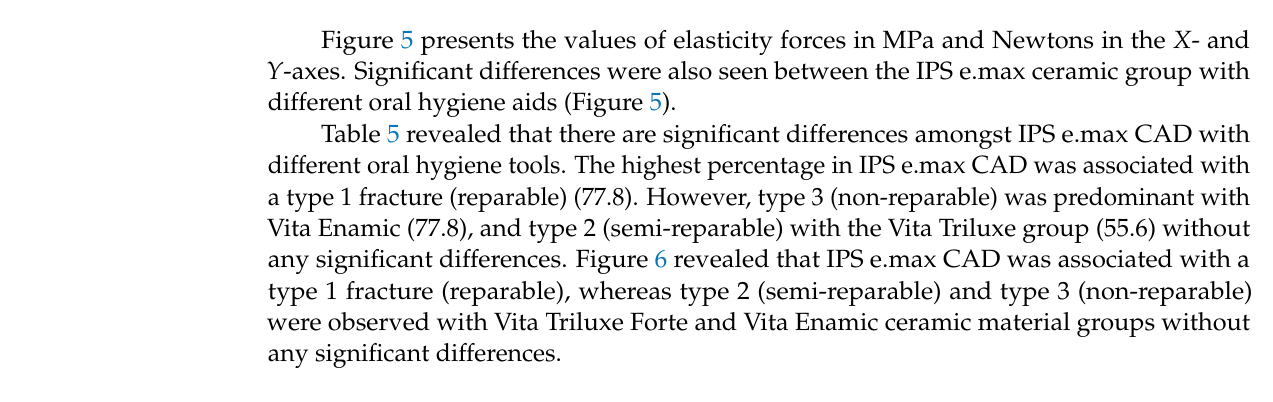
Table 5. Fracture type percentages among different ceramic